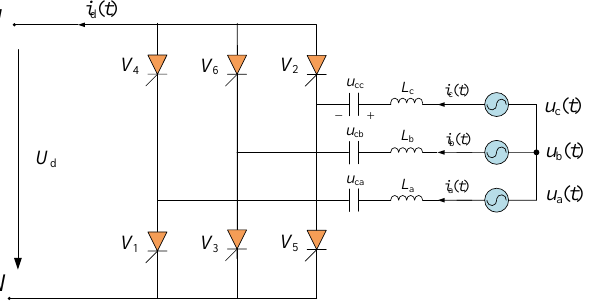
Figure 2. Diagram of a six-pulse CCC equivalent model at the inverter side.